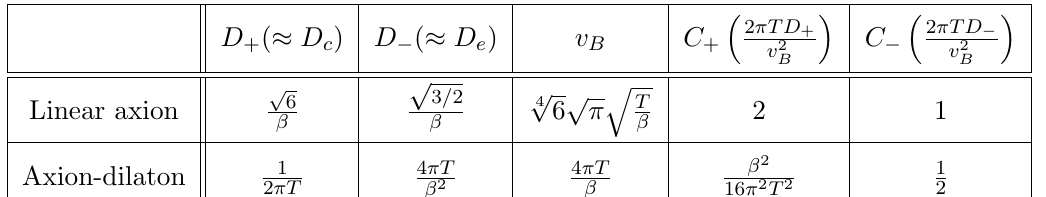
Table 1 . Summary of the results: di(cid:11)usion constants for the linear axion model and axon-dilaton model in the incoherent regime (cid:12)=T (cid:29) 1 and (cid:12)=(cid:22) (cid:29) 1.